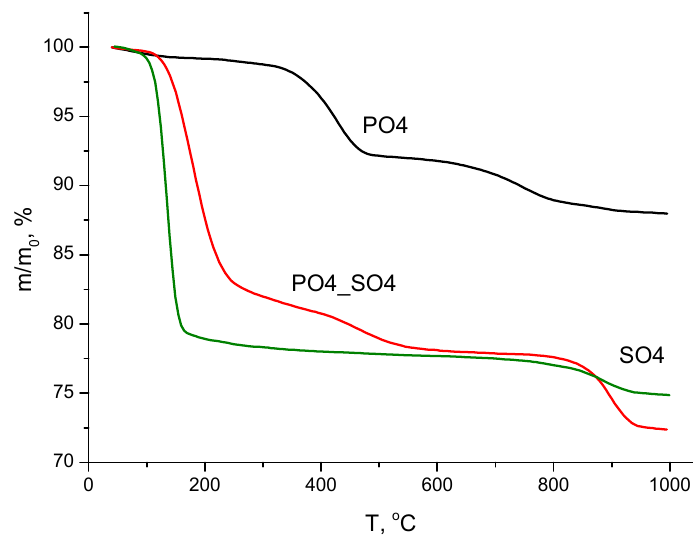
Figure 6. TG curves of powders synthesized from aqueous solution of calcium chloride CaCl 2 and sodium sulfate Na 2 SO 4 (green line); from aqueous solution of calcium chloride CaCl 2 and sodium hydrophosphate Na 2 HPO 4 (black line); and from aqueous solution of calcium chloride CaCl 2 and mixed-anionic solution Na 2 HPO 4 /Na 2 SO 4 (red line) after disaggregation in acetone.